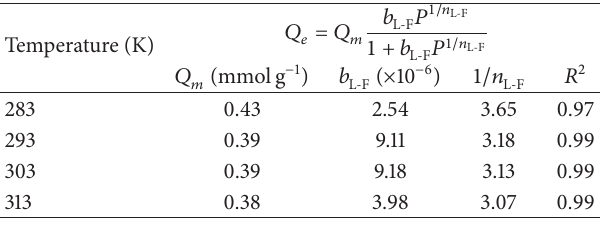
Table 2: Langmuir-Freundlich equation fitting of water vapor adsorption on the MFS-02 at 283–313 K.